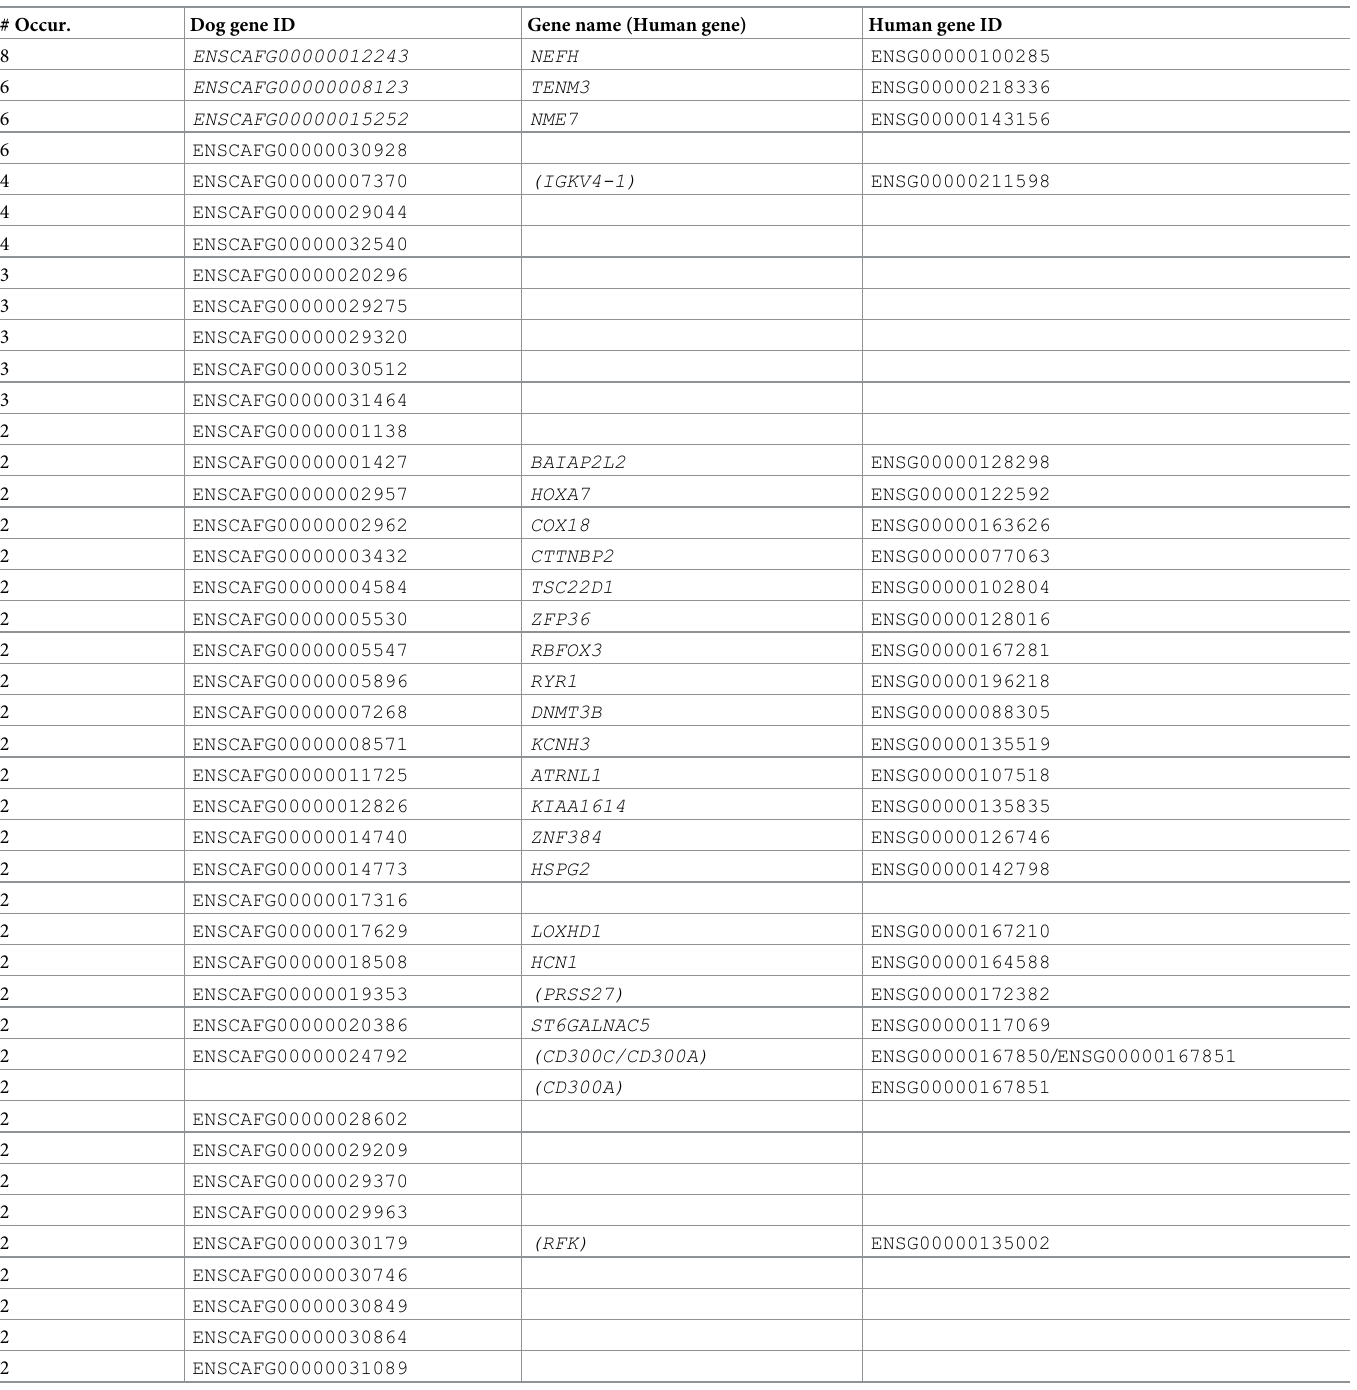
Table 5. Most commonly mutated genes and their human orthologues. #